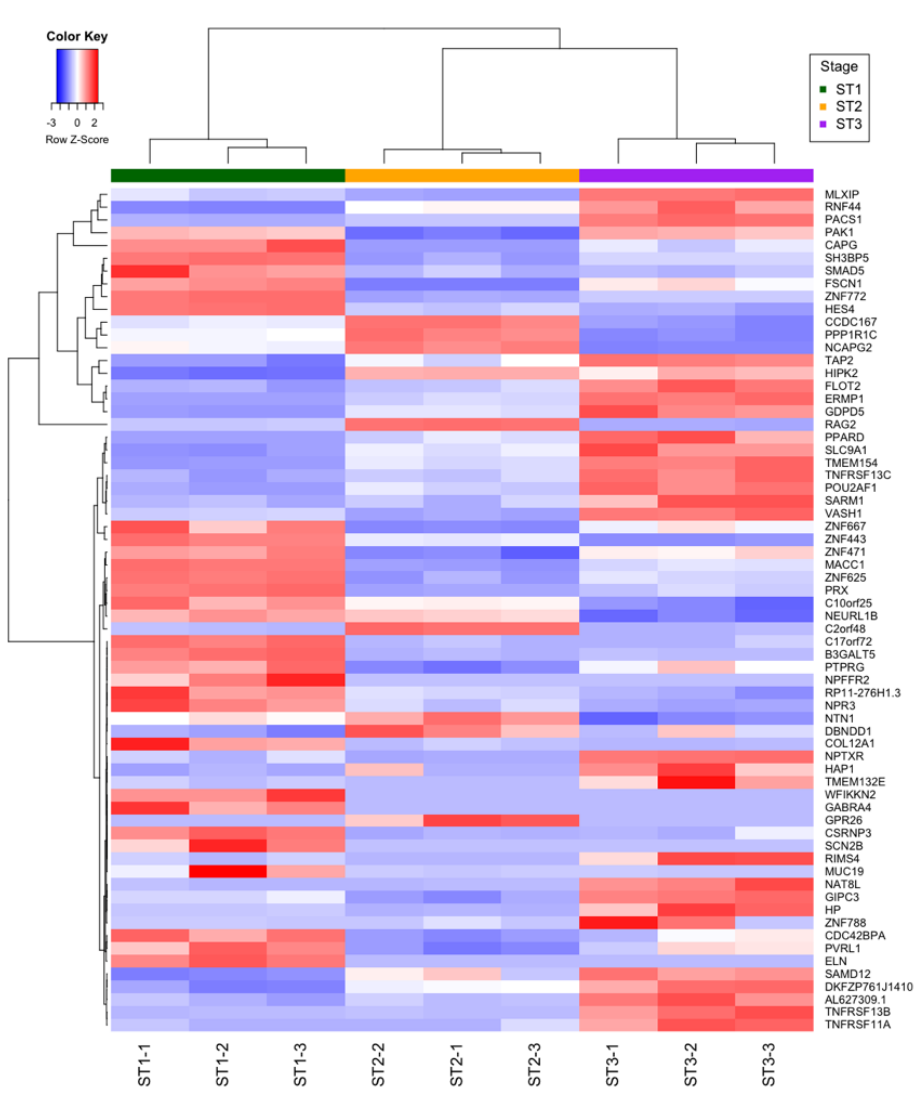
Figure 6. Expression patterns of the differentially expressed mRNAs (z-scores profiles by populations of thymocytes), According to all the parameters used during this work, we propose 3 as the most appropriate number of clusters of identified mRNAs.